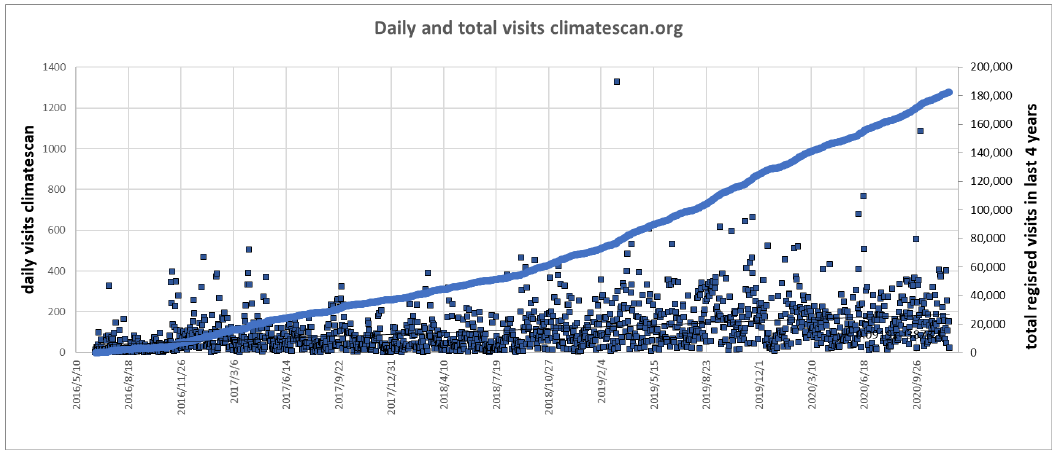
Figure 3. Daily and total visits of ClimateScan (based on data from Google Analytics).